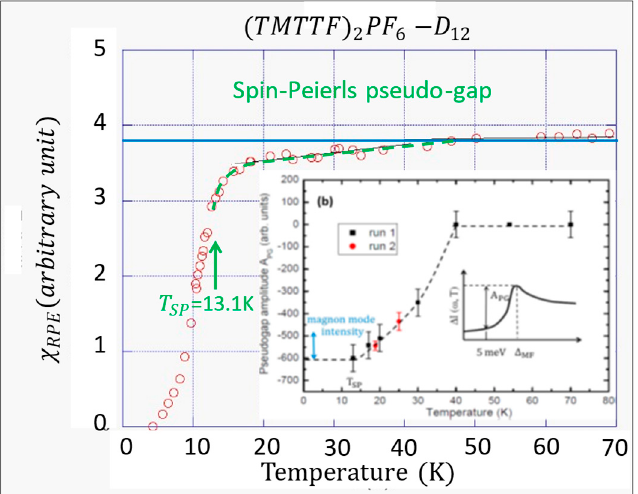
Figure 5. Spin susceptibility of deuterated TMTTF 2 PF 6 near the SP transition, showing the development of a pseudo-gap below 40 K ( χ RPE has been kindly provided by C. Coulon). The inset gives the thermal dependance of the amplitude of the pseudo-gap at 5 meV in the same T range. The energy dependence of the pseudo-gap, obtained from neutron measurements [32], is also schematically represented